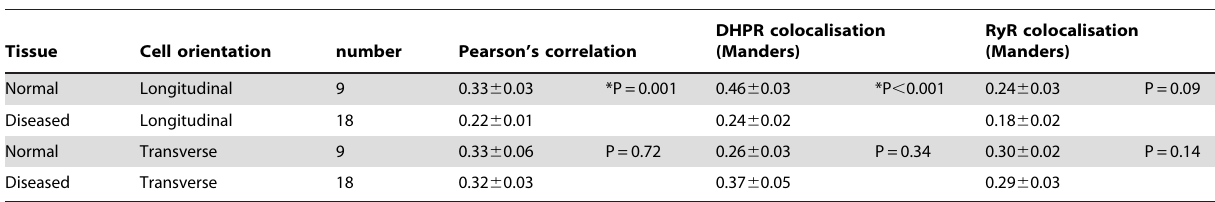
Table 1. Colocalisation analysis of DHPR and RyR